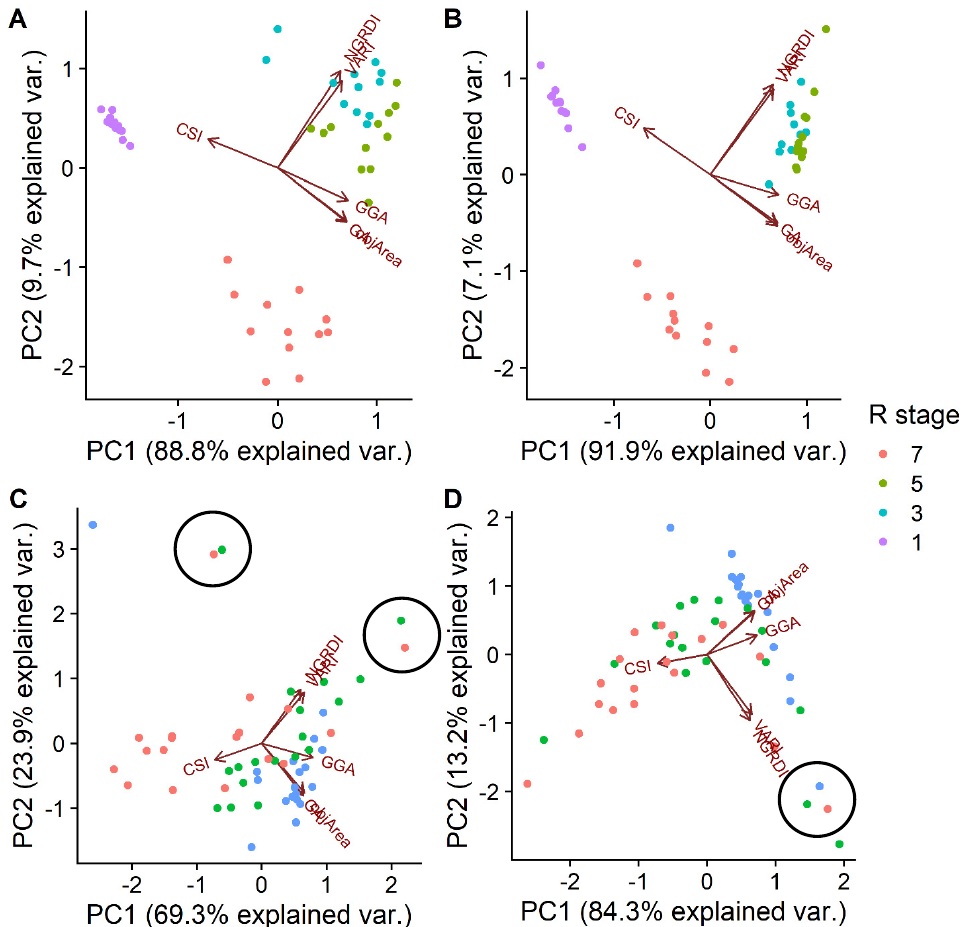
Figure 4. Biplot of first and second principal components showing genotype clusters across growth stages. ( A , C ) Medium duration population in 2020 and 2021. ( B , D ) Short duration population in 2020 and 2021.